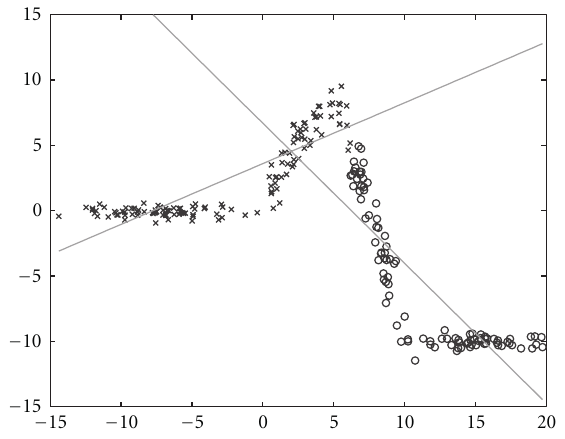
Figure 4: Initialization of hyperplane clustering for M = 2. Patterns belonging to the new generated clusters are represented by the symbols “x” and “o”, respectively; the first estimate of hyperplanes based on these subsets is shown by the continuous gray lines.